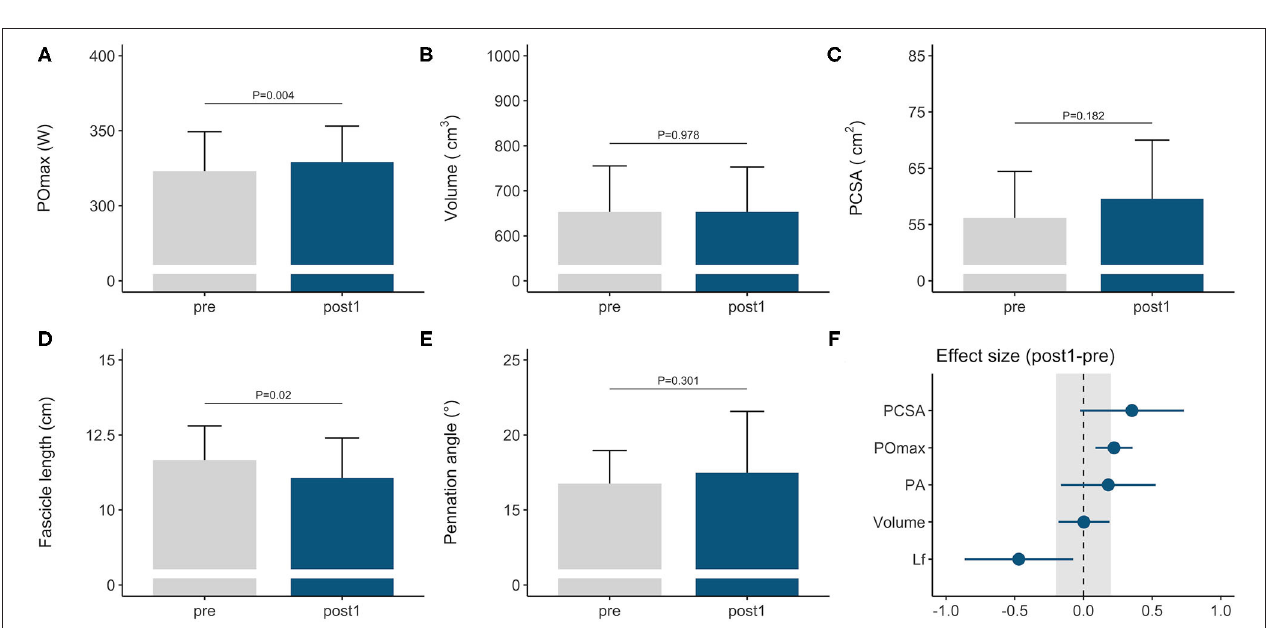
FIGURE 1 | Morphological and functional responses to the general preparation phase in elite female rowers. Functional response is shown for (A) maximal power output obtained on a rowing ergometer during concurrent endurance and high-load resistance training. Morphological responses are shown for m. vastus lateralis (B) volume, (C) PCSA, (D) fascicle length, and (E) pennation angle. Standardized ESs and their 95% confidence intervals (in Cohen’s d ) are reported in (F) for the pre–post differences. The gray area in (F) highlights the smallest worthwhile change (|ES| 0.2), illustrating what effects can considered to be non-trivial. PCSA, = physiological cross-sectional area; POmax, rowing ergometer power output in the final 4min of a maximal incremental test; Lf, fascicle